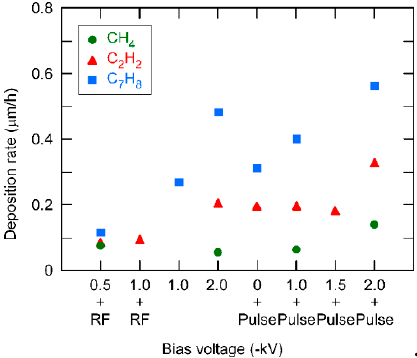
Figure 1. Deposition rates of the single DLC layers prepared with different conditions as indicated. The bias voltage consists of a DC voltage (upper line of the x -axis label) and / or a pulse voltage or an RF voltage (the latter applied at the electrode plate).